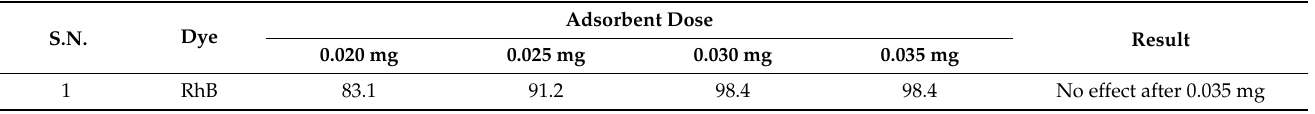
Table 8. Percentage of RhB dye adsorbed by different doses of the as-prepared AC (Db-s). S.N.